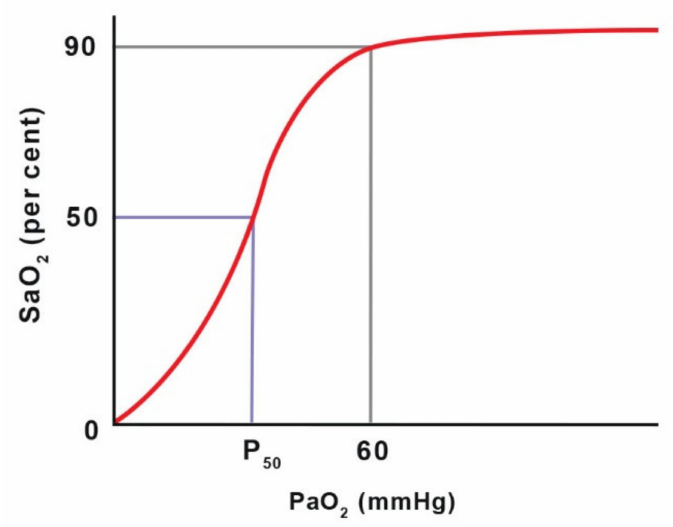
Figure 1. The haemoglobin dissociation curve shows the relationship between oxygen partial pressure (PaO 2 ) and haemoglobin oxygen saturation (SaO 2 ). P 50 is the PaO 2 value at which 50% of haemoglobin is saturated with O 2 at a blood pH of 7.4 and temperature of 37 ◦ C. Adapted with permission from [63] Copyright 2016 John Willey and